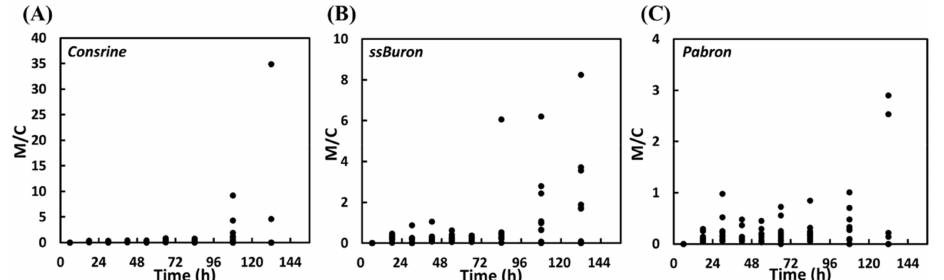
Figure 3. Ratios of the clinical concentrations of total morphine and total codeine (M / C) in the urine samples from the ten participants orally administered the cold syrups ( A ) Consrine, ( B ) ssBuron, and ( C ) Pabron.